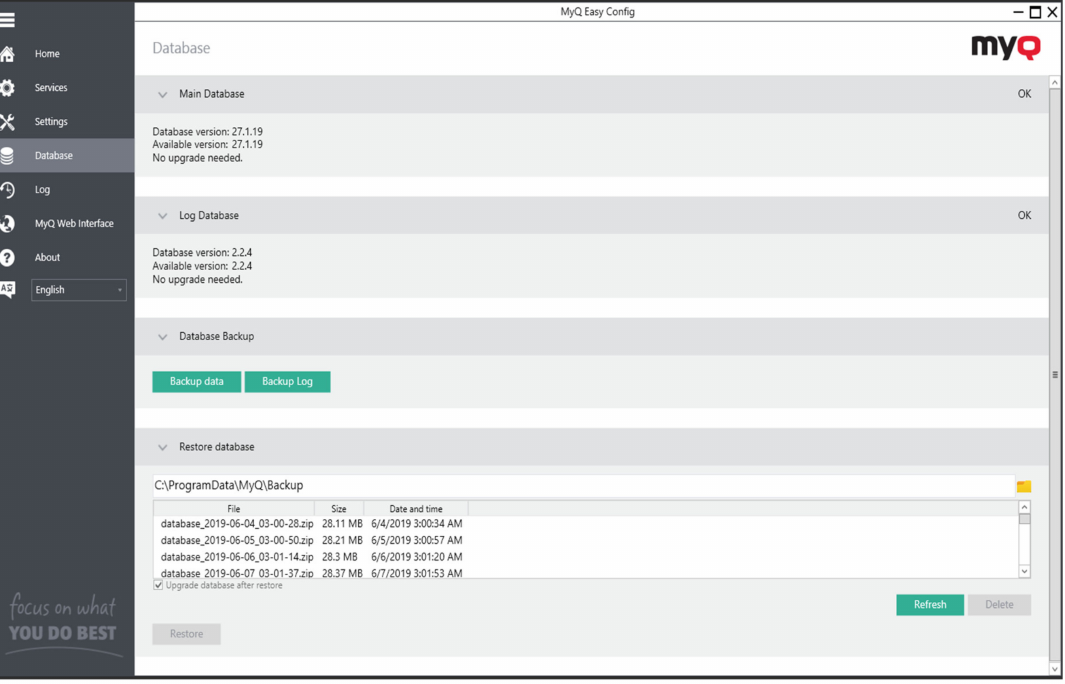
Figure 3. MyQ Easy Config Initial Program. Source: custom